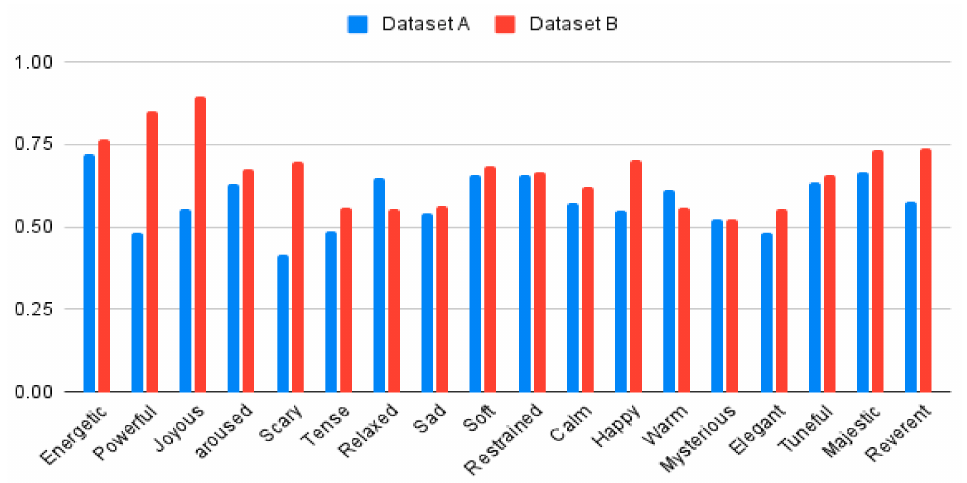
Figure 9. Comparison of ROC-AUC Performance Results of Dataset A and Dataset